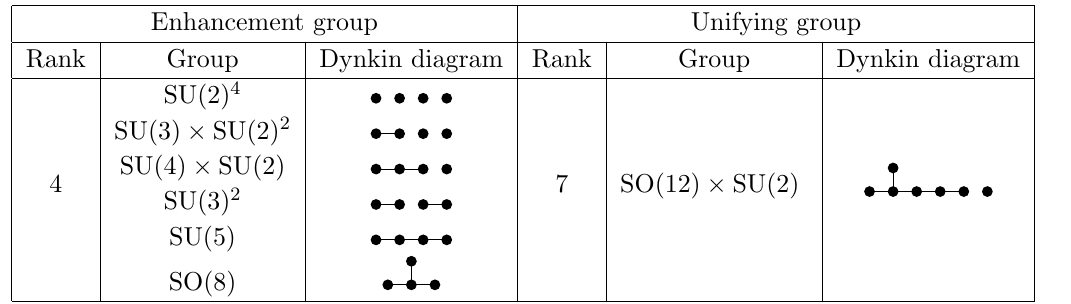
Table 5 . The case T 3 .